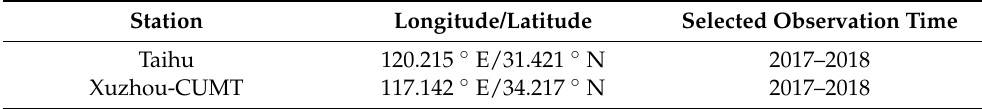
Table 2. Summary of AERONET